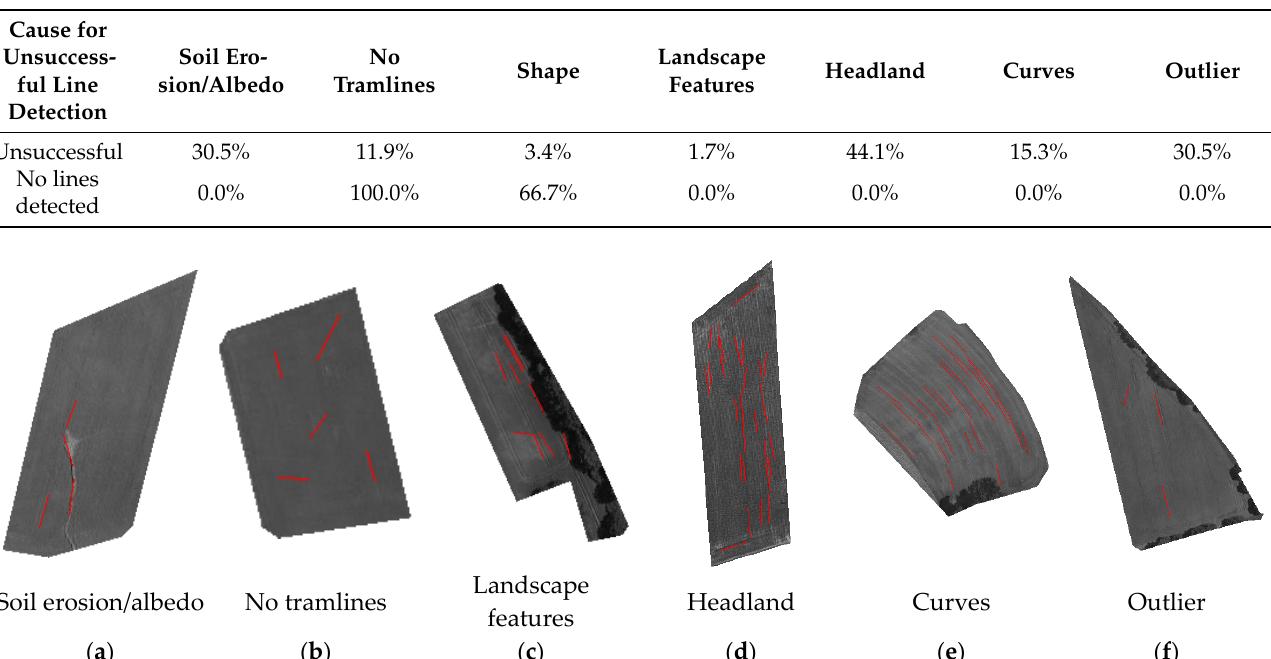
Table 9. Percentage distribution of reasons for unsuccessful line detection; partly multiple reasons for one image. Cause for Unsuccessful